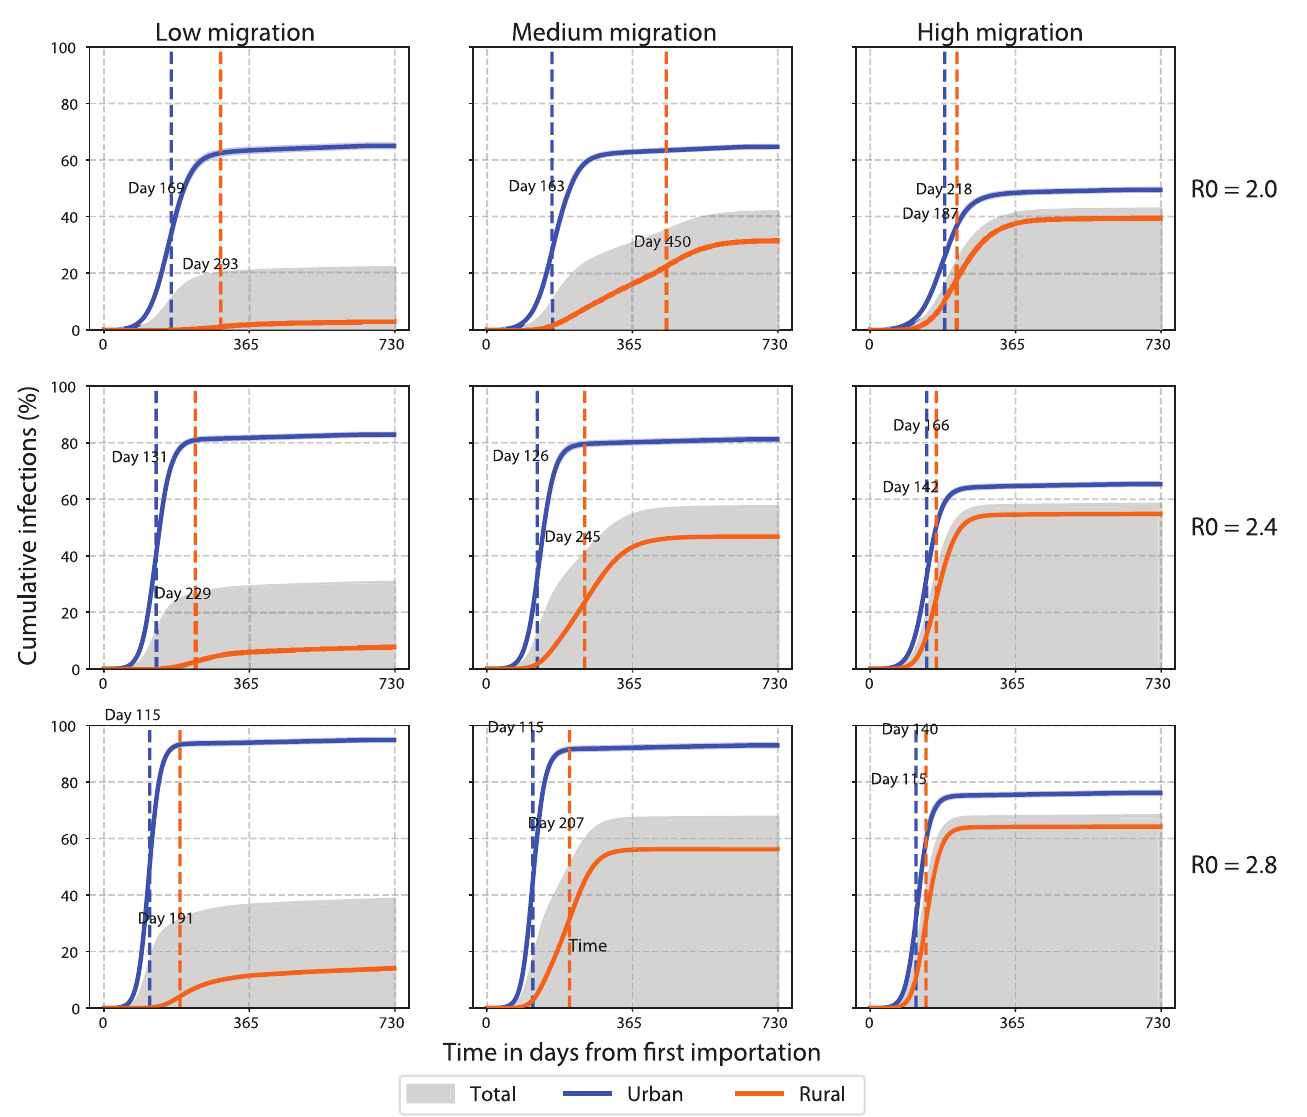
Fig 7. Cumulative COVID-19 incidence with varying transmission and migration in an archetypal SSA country. Urban and rural curves show percentage ever infected out of a population of 400 000 individuals split 40% urban and 60% rural. Peak percentages represent cumulative incidence as a percentage of the respective sub-population on the date when the highest incidence in each sub-population occurs indicated by the dashed vertical line. Time in days since first imported case. Low, medium, and high migration = 2000, 20 000, and 200 000 dtpmi, respectively.